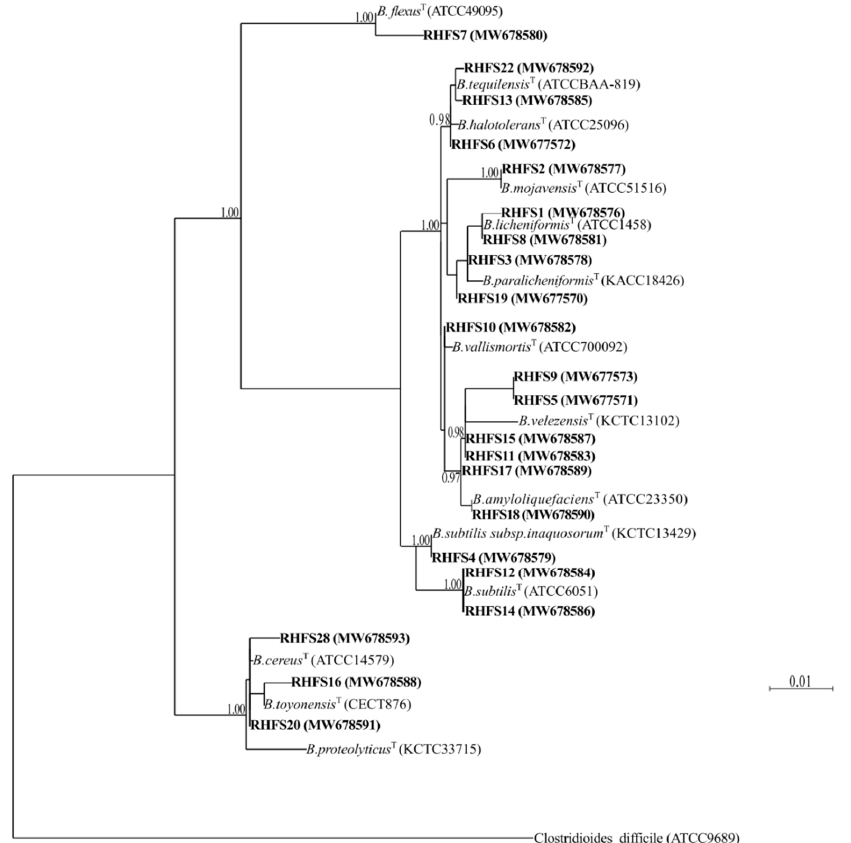
Figure 1. Phylogenetic tree of isolated rhizobacteria. The phylogenetic tree was constructed using the maximum-likelihood algorithm based on 16S rRNA gene sequences. The gene sequences of the isolated bacteria were aligned to the representative type strains ( T ). The numbers in parentheses indicate the GenBank accession numbers. The percentage of replicate trees in which the associated taxa clustered together in the bootstrap test (1000 replicates) is shown next to the branches. The 16S rRNA sequence of Clostridioides difficile (ATCC9689) was used to assign an outgroup